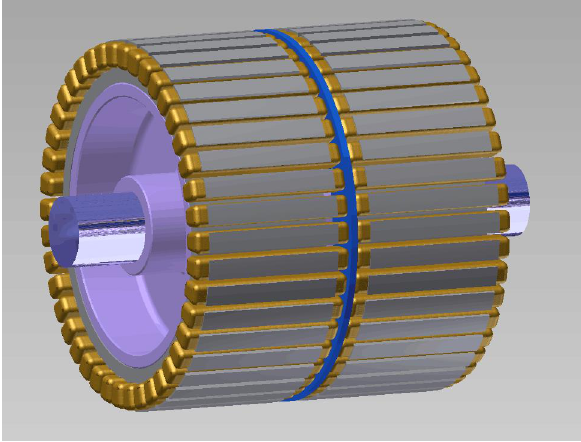
Figure 25. Diagram of the stator with two twisted modules.